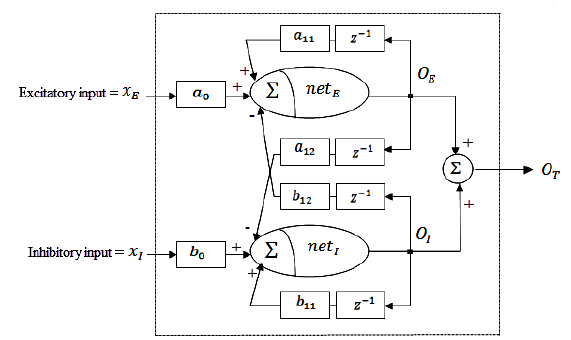
Figure 1. Structure of dynamic neuron [29].